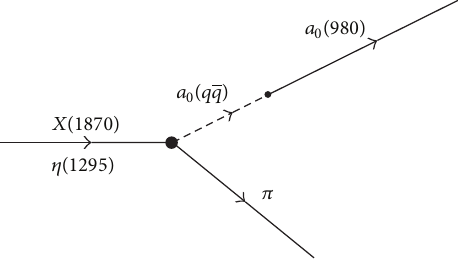
Figure 7: The diagram for the “ S + 𝑃 ” channels through a virtual intermediate 1 3 𝑃 0 𝑞𝑞